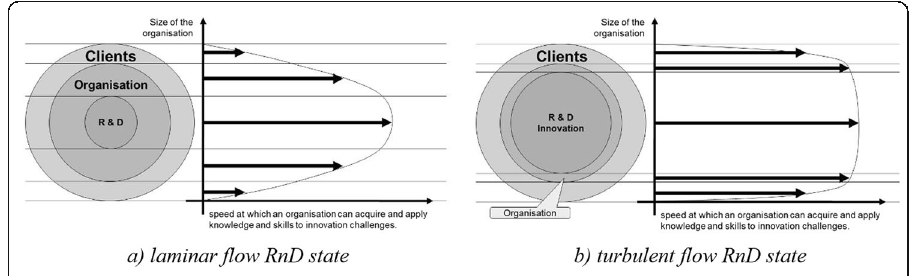
Fig. 22 Possible laminar to turbulent transition impact on the RnD